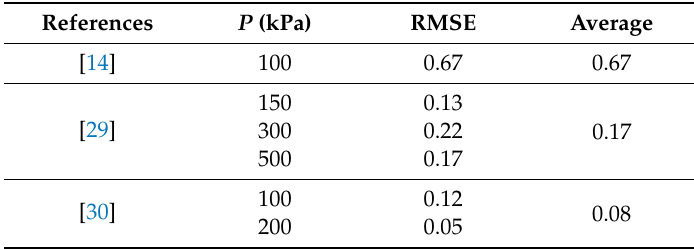
Figure 12. Comparison of the calculated and measured frost heave from ( a ) Lai et al. [14], ( b ) Zhang et al. [29], ( c ) Ming et al. [30]. Table 5. RMSEs of the three soil